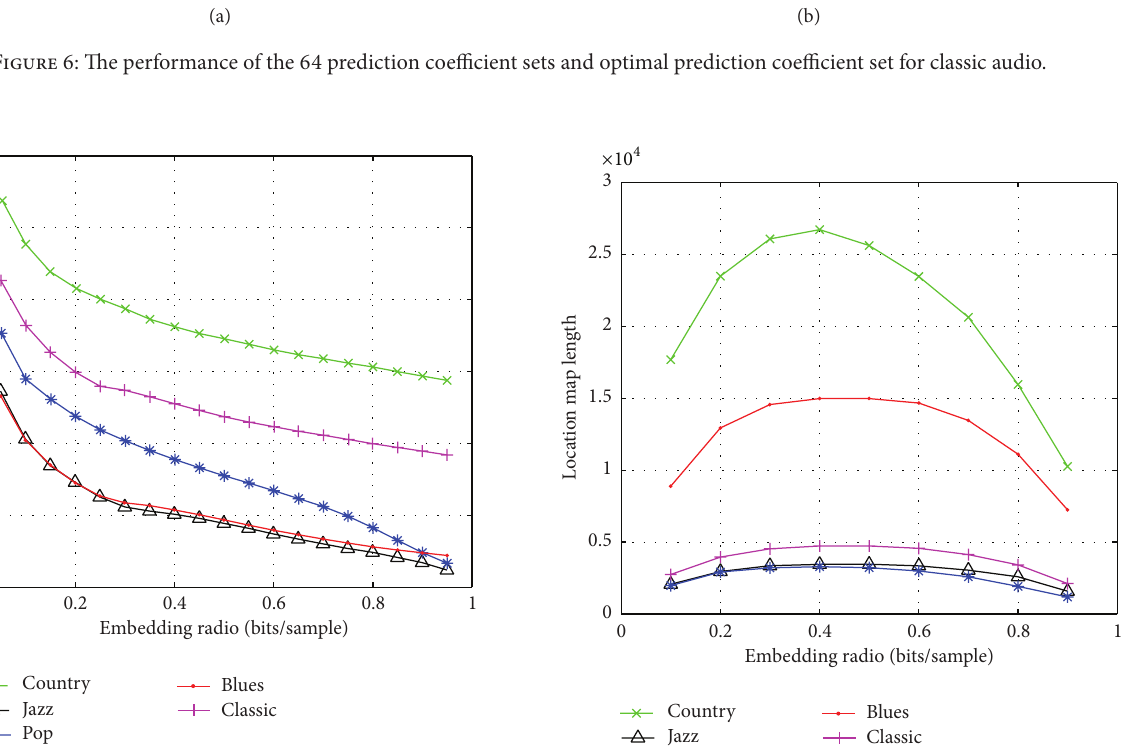
Figure 7: The embedding capacity versus the embedded.